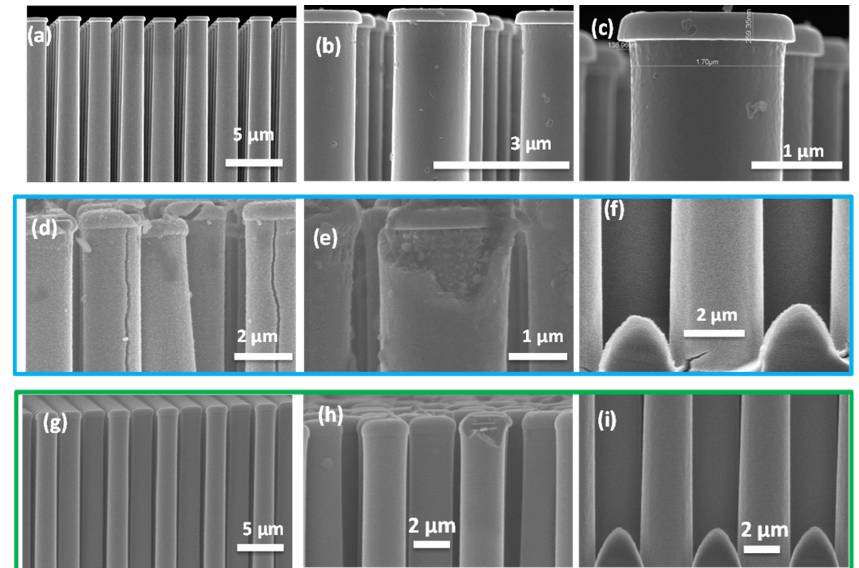
Figure 5. Scanning electron microscopy images showing the TiN silicon pillars ( a – c ) before carbon and EMD deposition. Cross-sectional SEM images for EMD anodically deposited on carbon-coated TiN/Si pillars under 4.5 mA/cm 2 (effective current 0.2 mA/cm 2 ) for 100 s at room temperature of 22 °C; ( d – f ) and at a bath temperature of 40 °C; ( g – i ). All EMD films were deposited from an aqueous bath of MnSO 4 (0.3 M) in H 2 SO 4 (0.3 M), without agitation.